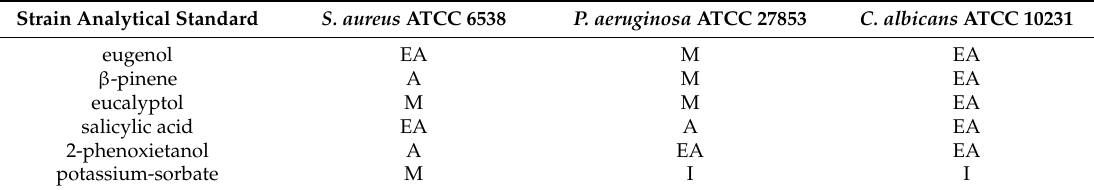
Table 1. Qualitative screening of the antimicrobial activity results; EA—Extremely active substances (>20 mm growth inhibition zone), A—active substances (15–18 mm), M—Moderate antimicrobial